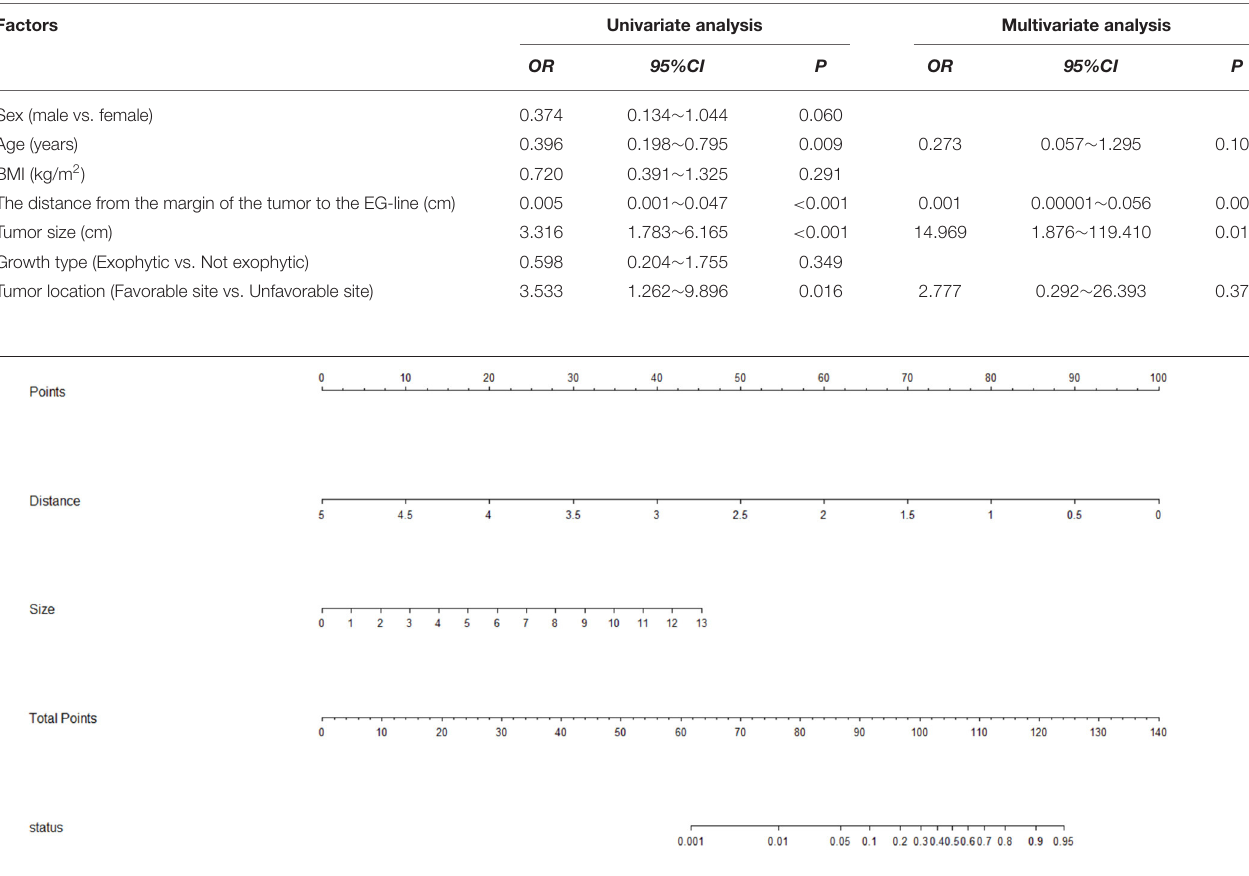
had a bootstrapped C-index of 0.988 (calibrated C-index = 0.987) with broad calibration ( Figure 3